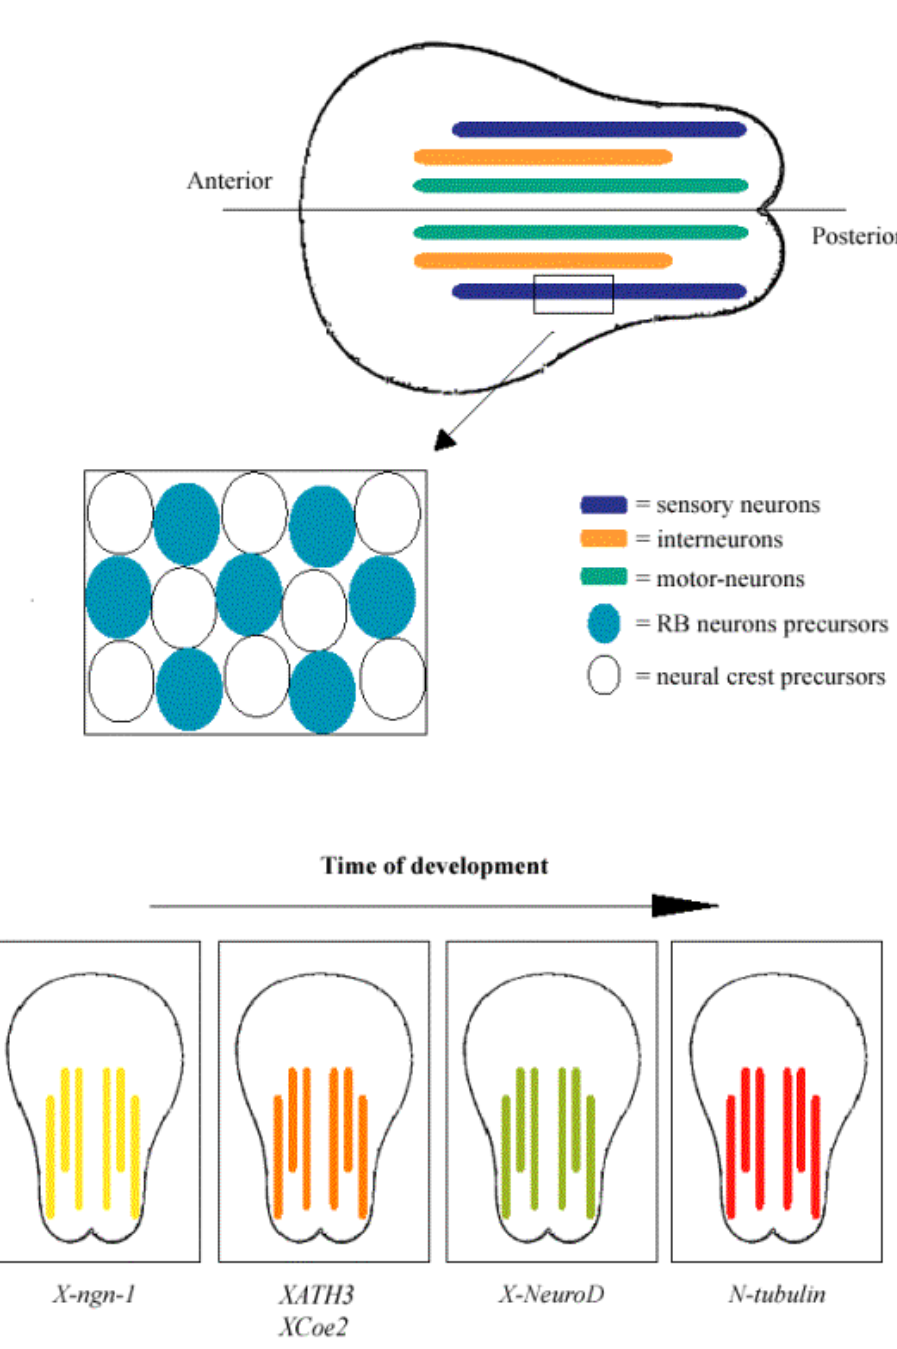
FIGURE 3. The primary neurogenesis in frog and zebrafish. (Upper part). Drawing of the neural plate depicting the three bilateral of primary neurogenesis. A portion of the lateral sensory stripe is highlighted in the insert. Two types of neural precursors are found, those of the Rohon-Beard (RB) neurons and premigratory neural crests precursors. (Lower part). Four successive stages (from left to right) of primary neurogenesis are depicted, showing some genes whose expression is initiated at that particular stage. For the sake of simplicity, only the initiation of the expression is shown. Nevertheless, when XATH3 and XCoe2 are first expressed, X-ngn-1 is still expressed. Similarly, XATH3 and XCoe2 expression overlaps that of X-NeuroD, which overlaps that of N-tubulin.